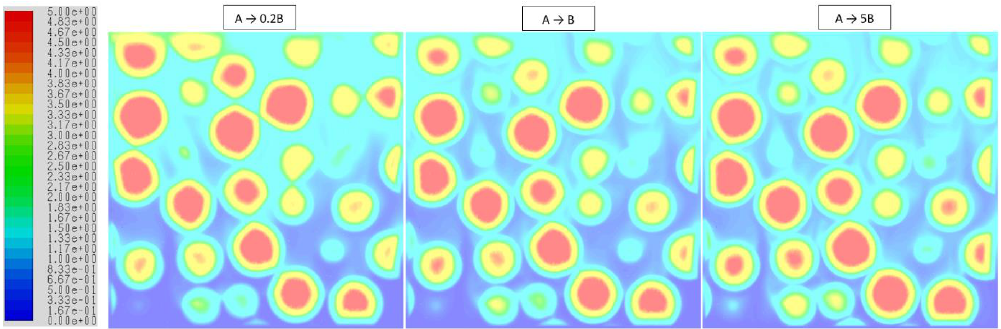
Figure 8. PR-DNS predictions of the reactant concentration (specie A) for different reactions (Table 3) (at plane y = 0; ε = 0.352, 𝜙 = 10, Pr = 1) through a bed of porous spherical particles. [Note: The contours shown above are expressed on a scale (−log 10 (x A )); Blue suggests high, while Red means minimum].